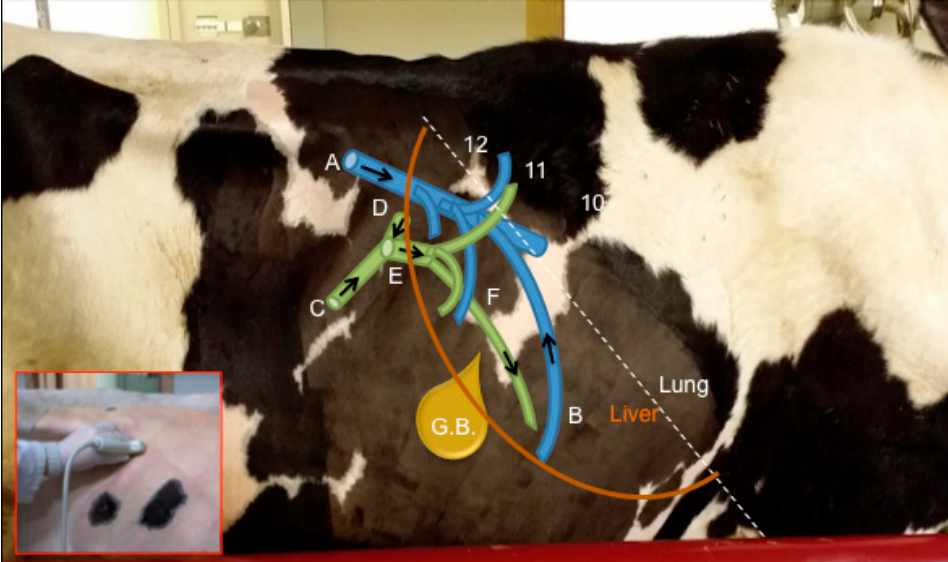
Figure 1. Schematic drawing of the main vessels included in this study. Blue vessels = A—Caudal vena cava, B—Hepatic vessels; Green vessels = C—Cranial mesenteric vein, D—Splenic vein, E—Main Portal vein, F—Portal branches. G.B. = Gall Bladder. Arrows show direction of blood. Numbers indicate specific intercostal